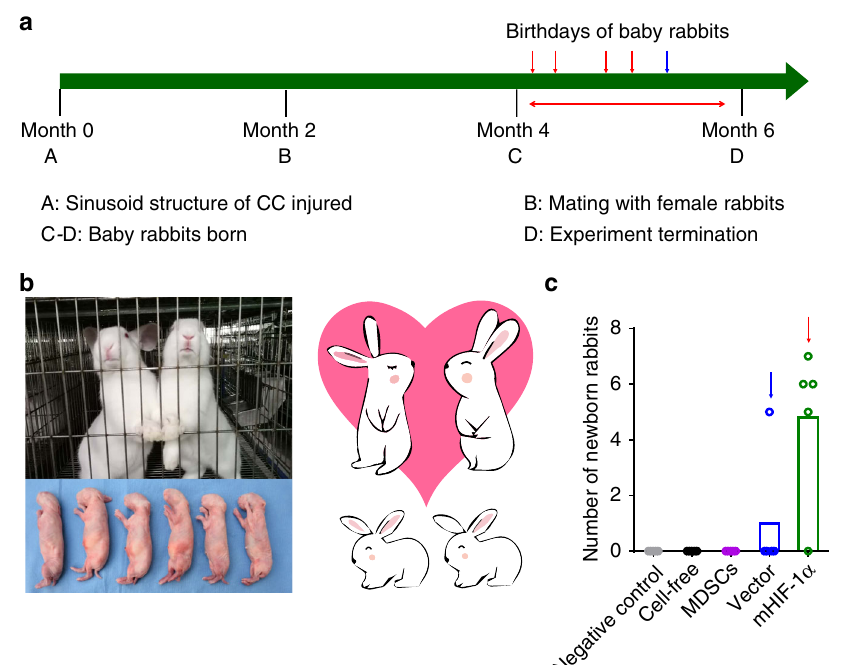
Fig. 7 The birth time points and the numbers of newborn rabbits after different treatments in the fi ve different groups. a Timeline of the experimental steps in the mating assessment. The arrows indicate the birth time points of newborn rabbits in the vector group (blue arrows) and the mHIF-1 α group (red arrows). CC, corpus cavernosa. b The baby rabbits were born in one cage of the mHIF-1 α group within after 2 months of the mating assessment. c The numbers of newborn rabbits in each group within 4 months of the mating assessment test ( n =